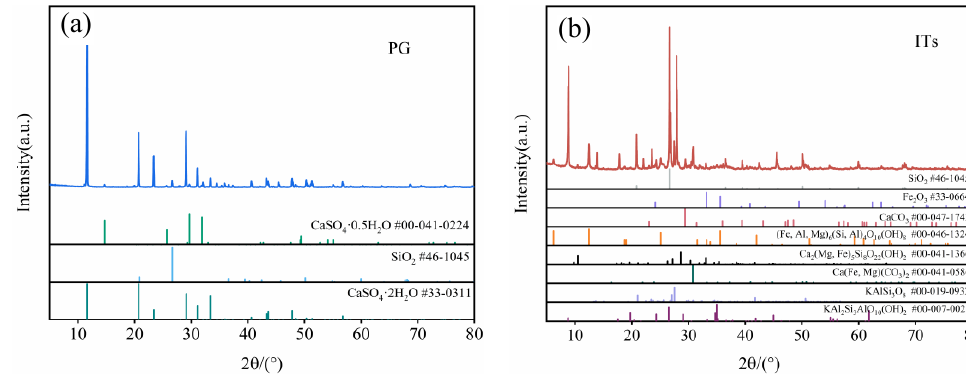
Figure 2. X-ray diffraction patterns of PG ( a ) and ITs ( b ). Table 1. The main chemical compositions of ITs, PG and binder. Chemical